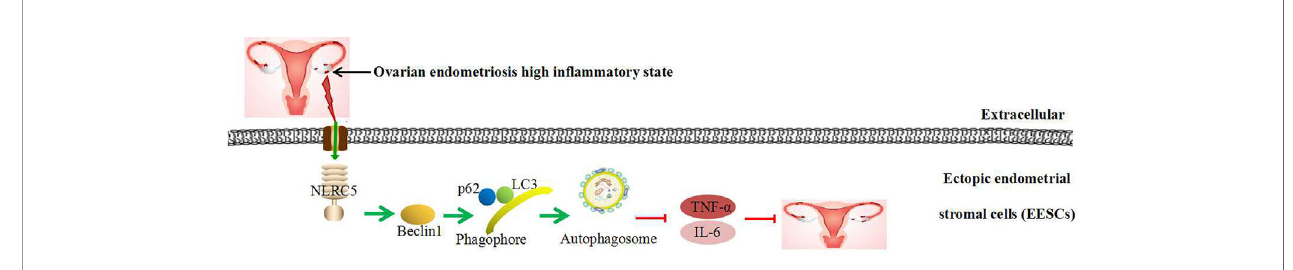
FIGURE 7 | Schematic diagram of NLRC5-regulated autophagy in EESCs of